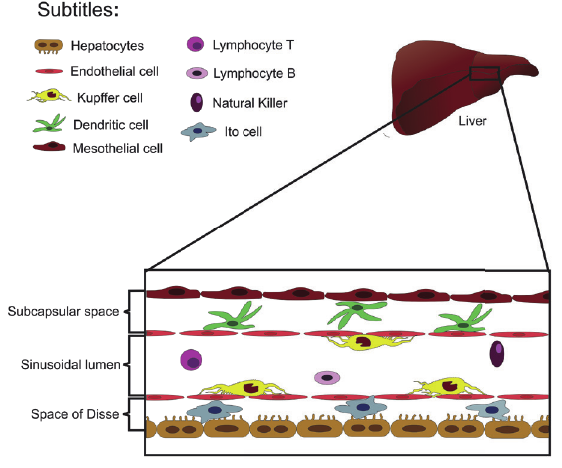
Figure 1 - Schematic representation of liver cell populations. In addition to the parenchymal cells, diff erent immune cell subtypes inhabit the liver. Dendritic cells are mainly located underneath the liver capsule (mesothelial cells), while Stellate cells (also known as Ito cells) are in a narrow space separating the sinusoid from hepatocytes, called space of Disse. Macrophages are exclusively found lining the sinusoidal endothelium (also known as Kupffer cells) while in the lumen, there is a plethora of resident leukocytes, including lymphocytes, monocytes and eventual